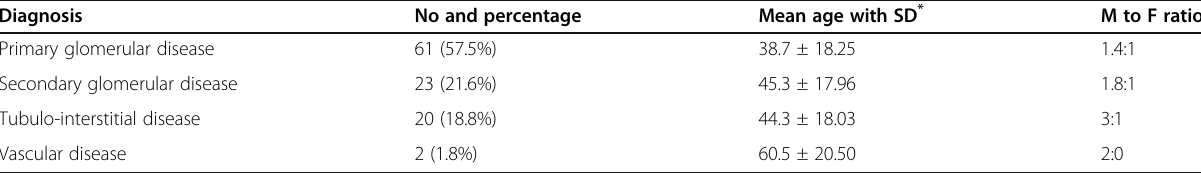
glomerular disease, with all cases occurring in patients